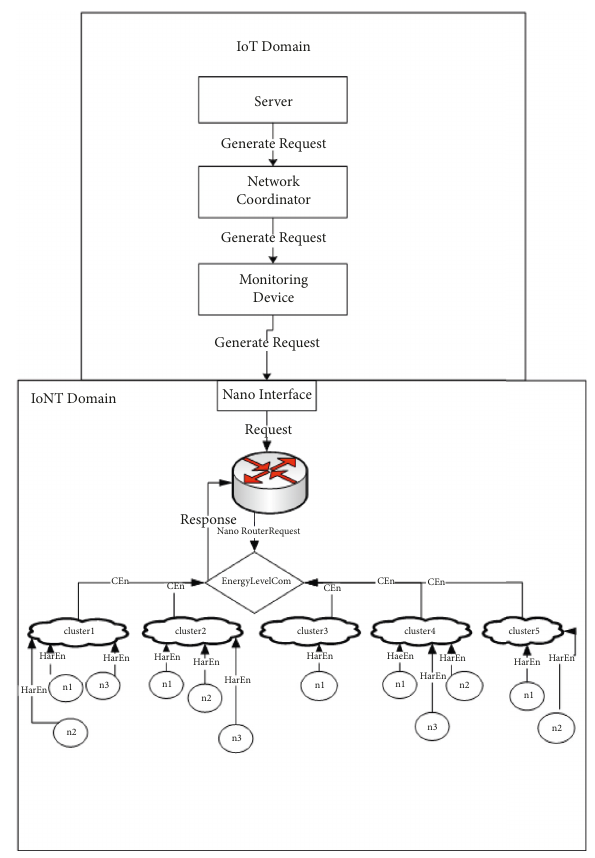
Figure 12: Message request